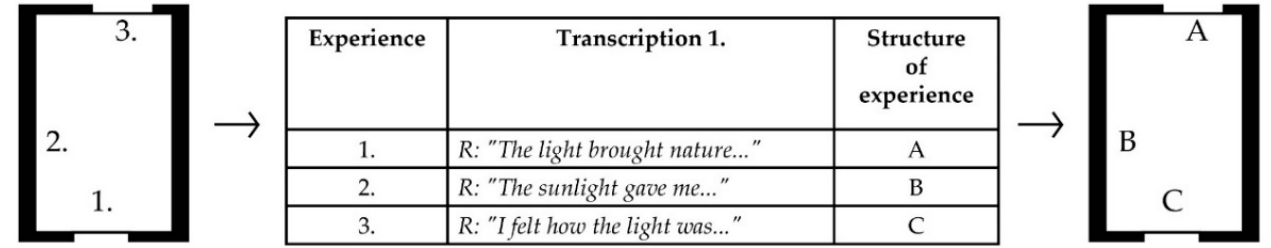
Figure 4. A fictitious example of how the experiences (1., 2., 3.) in a certain location is numbered on the floorplan and in the transcript. Each part of transcript is analysed to find a structure (A, B, C) that can be localised on the floorplan.